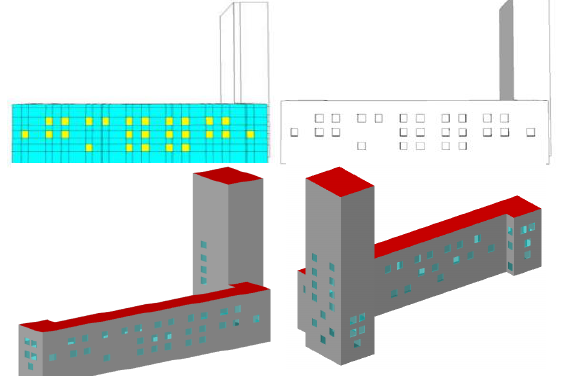
Figure 4. (a): Cell decomposition of façade shown in middle row of figure 7, (b): Reconstructed model, (c) and (d): Enriched CityGML LOD3 model